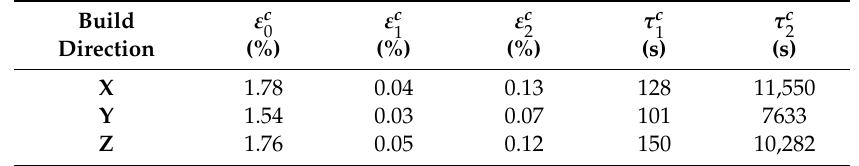
Table 4. Parameters describing the creep curves for the specimens fabricated through SLS from